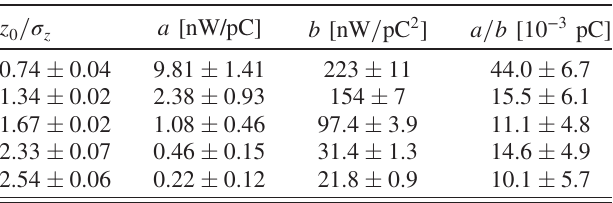
TABLE III. Fit parameters of the dashed curves in Fig. 13. z = σ 0 z